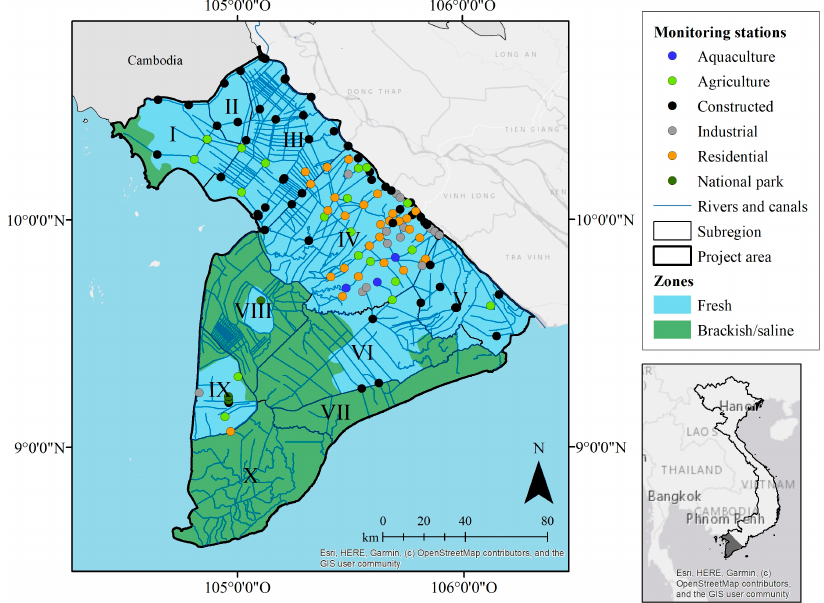
Figure 1. Freshwater monitoring stations within the project area and subregions (I–X) during dry season.